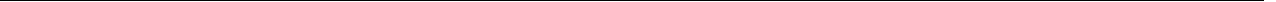
Fig. 6 CM-SASP induces senescence in a paracrine manner. a Schematic representation of the experiment. Biliary cells are cultured with SASP-conditioned media (CM-SASP) and Control-conditioned media (CM-Ctrol). After 1 week, different markers of senescence were evaluated. b Number of total Ctrol- treated biliary cells increase (suggesting that they continue proliferating). Total number of CM-SASP-treated biliary cells plateau , indicative of an impaired proliferative response. **** denotes p < 0.0001 (Mean ± SEM). Mann − Whitney test. N = 7 – 8 biological replicates. c qRT-PCR shows a signi fi cant increased expression of cdkn1a (p21), cdkn1b (p27) and cdkn2a (p16) in the CM-SASP-treated biliary cells at day 7. * denotes p < 0.05 (Mean ± SEM). Mann − Whitney test. N = 4 biological replicates. d Morphological changes observed in the cell cultures. CM-SASP-treated biliary cells become fl atter, larger and their content is vacuolized. e Increased SA- β Gal (red) expression in CM-SASP-treated biliary cells with decreased BrdU incorporation (green). Far right, total percentage of SA- β Gal or BrdU per DAPI-positive nuclei per fi eld. f Increased expression of different senescence markers in CM-SASP-treated biliary cells compared with the CM-Ctrol-treated biliary cells. Below, total percentage of those markers per DAPI-positive nuclei. * denotes p < 0.05 (Mean ± SEM). Mann − Whitney test. N = 4 biological replicates. Scale bars = 50 µ